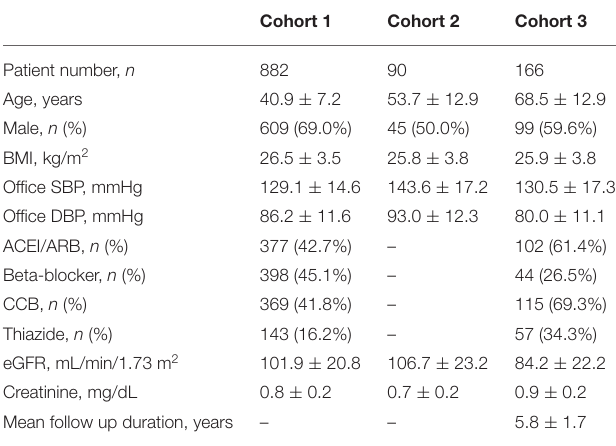
TABLE 1 | Baseline characteristics of the